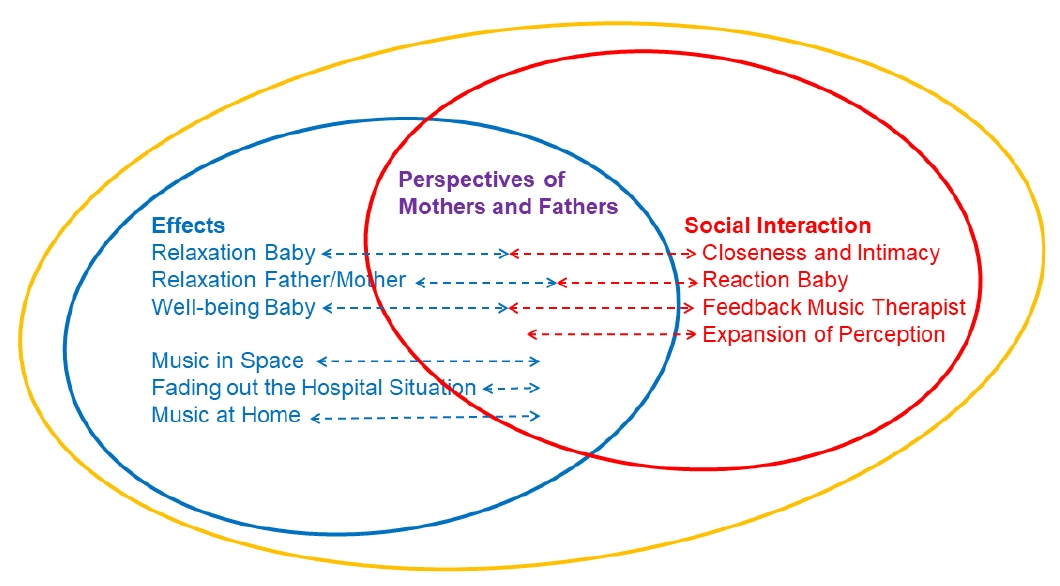
Figure 6. Graphic representation of the three main and six sub-themes that emerged from the thematic analysis.